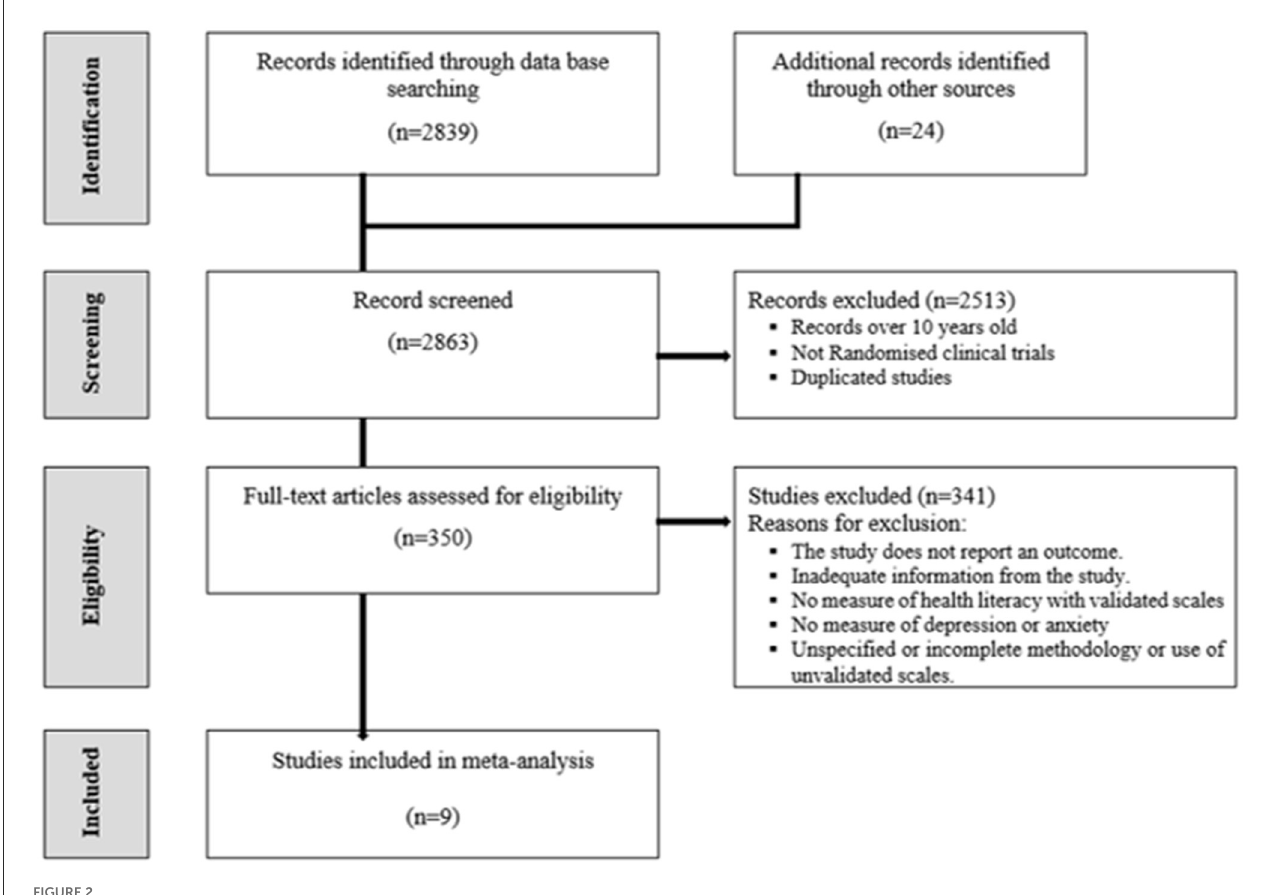
FIGURE2 PRISMA flowchart